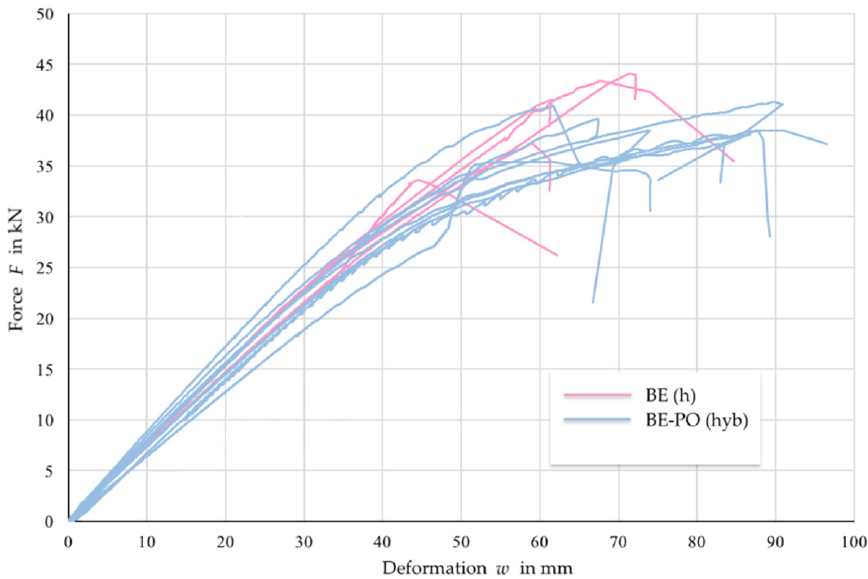
Figure 7. Graph of the F – w relationship for the glue-laminated beams; BE (h) stands for beech ho- mogeneous glue-laminated beams and BE-PO (hyb) stands for beech–poplar hybrid glue-laminated beams. The average maximum force for homogeneous beech beams (BE (h)) was reached at 39.98 kN (SD = ± 3.99 kN), and for the hybrid beech–poplar (BE-PO (hyb)), this was reached at 38.68 kN (SD = ± 1.78 kN). A higher deformation was found for the hybrid beams: 75.9 mm on average. The deformation of homogeneous beech beams was 60.1 mm on average. The values of bending strength are given in Section